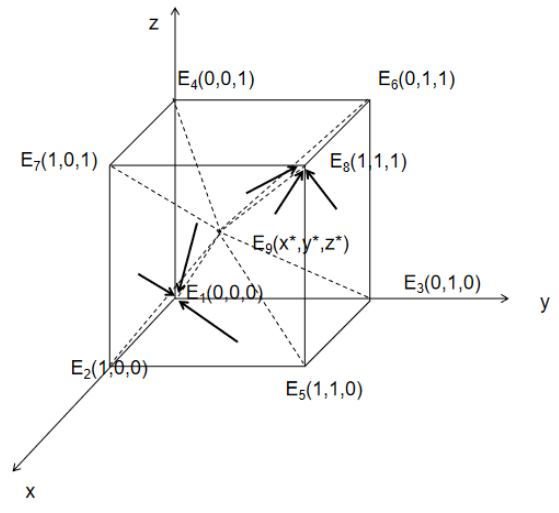
Figure 2. Tripartite main body dynamic evolution trend chart after a Public Health Emergency (About E 9 ). Table 6. The effect of the parameter changes on the action strategy.